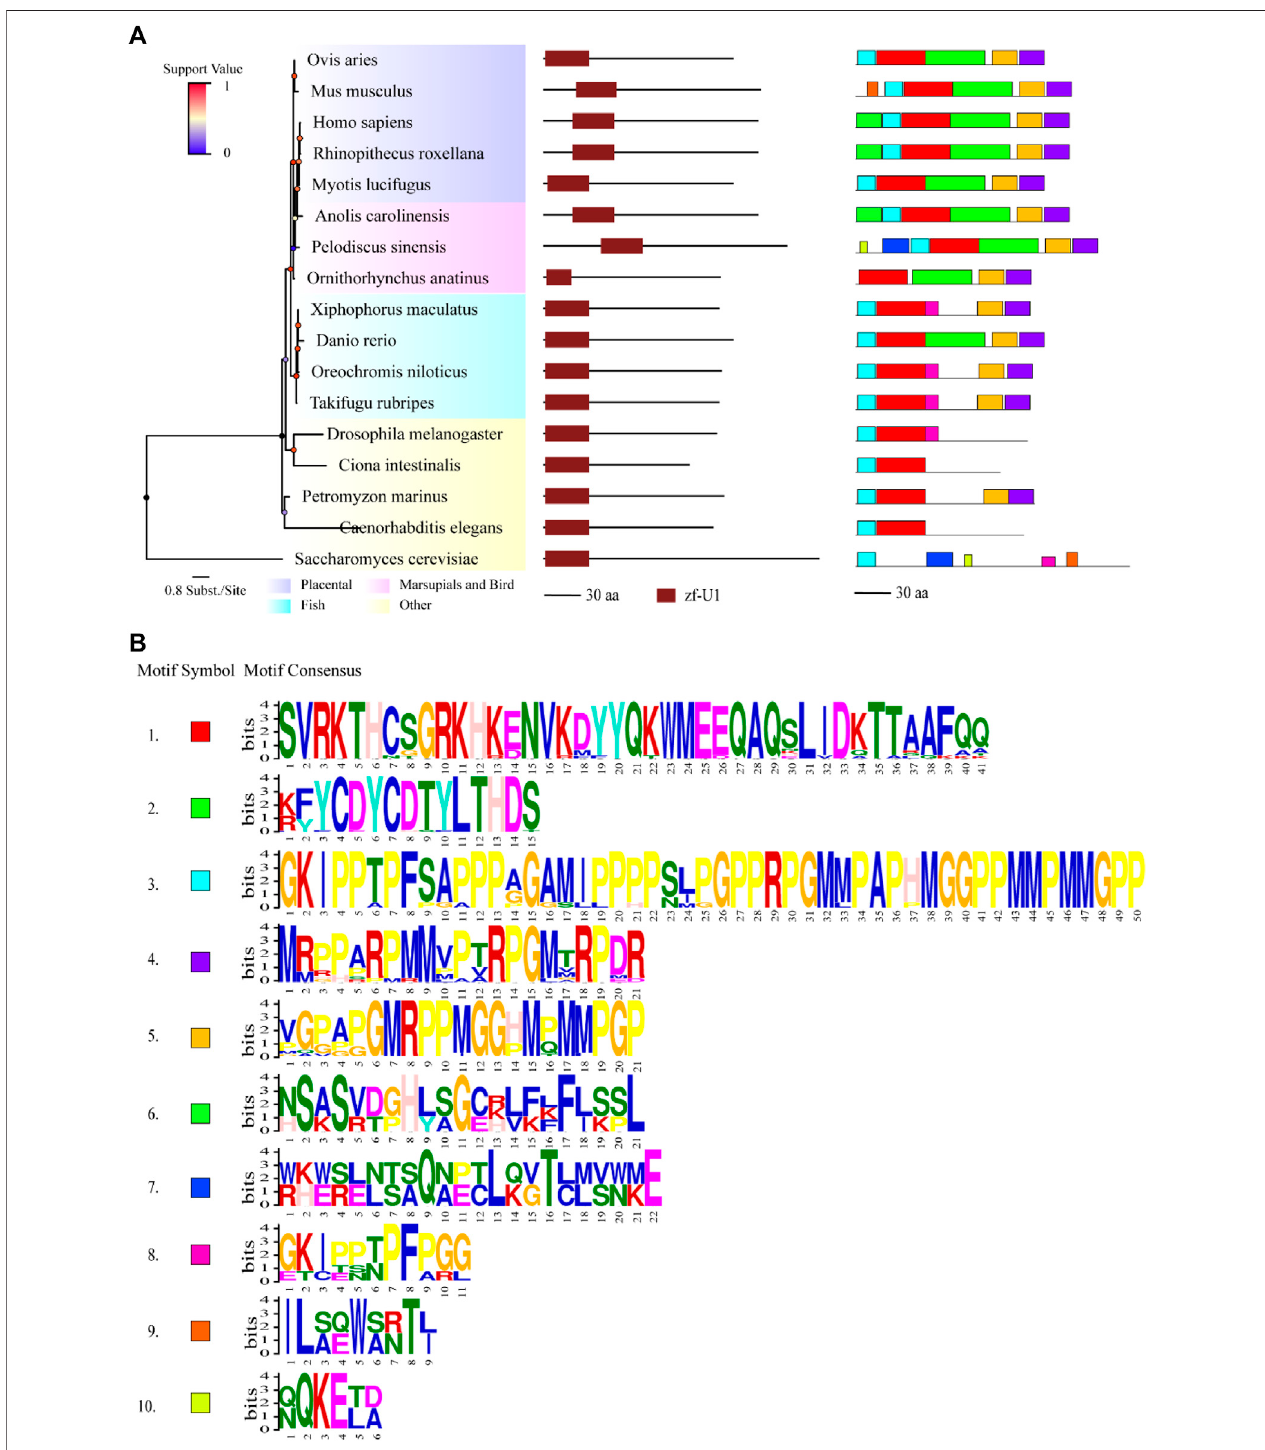
FIGURE1 | Comparisonsofstructure and motifanalysisof animal representative U1C proteins. (A) Theverticalphylogenetictree based on representative 17 U1C proteinsislistedontheleftpanel.Thelegendonthetopleftcornerrepresentssupportvalueofthetree.Blue/0tored/1meanstherangeofvalues.Thelengthofthescale bar corresponds to 0.8 substitutions per site. The predicted protein domains (zf-U1) by online HMMER are listed on the middle panel. The identi fi ed protein conserved motifs with MEME analysis are shown on the right panel. The 10 most frequently discovered motifs are shown in different solid colors and additional scanned sites ( p -values less than 0.0001) are shown in transparent color. (B) The logos and detailed information of ten motifs from MEME are shown below. The height of symbols indicates the degree frequency of each amino acid at that position. U1C sequences from human, mouse and C. elegens and yeast are highlighted by red arrow.